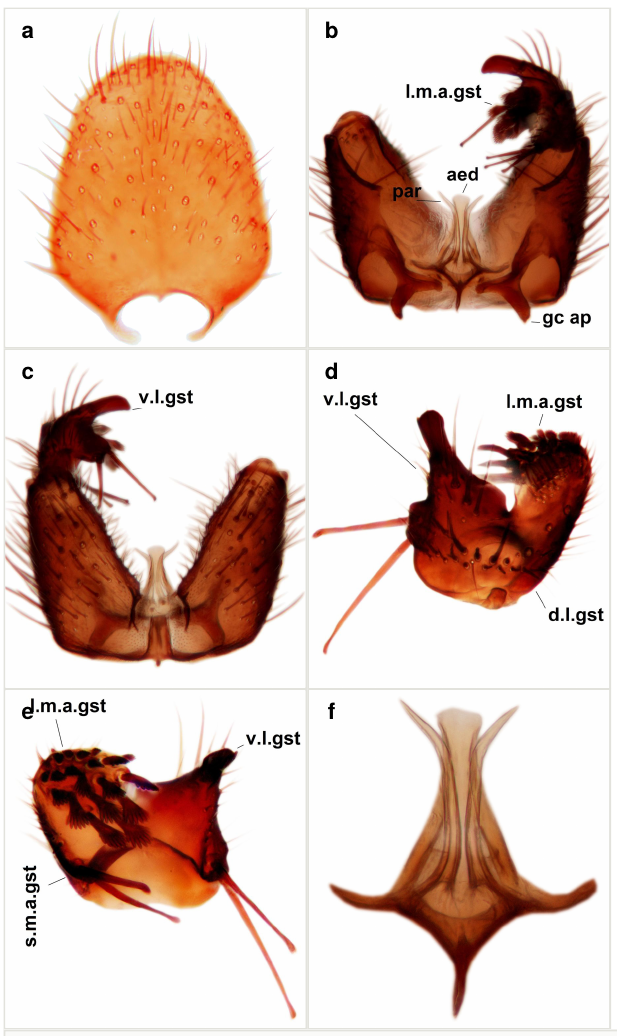
Figure 4. Sciophila holopaineni Salmela sp.n., holotype male, hypopygium. a : 9th tergite, dorsal